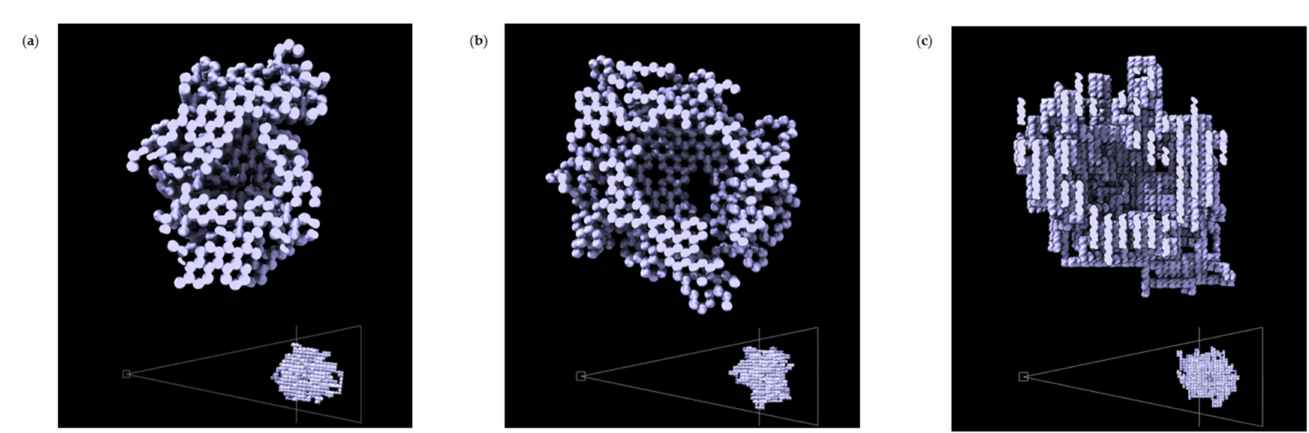
Figure 10. Isometric view of the best shapes generated with shape annealing algorithm for the coating application: ( a ) Slice view of structures generated with the tetrahedron mesh as the inner bounds of the design space with a total length of 12,901 bp; ( b ) Slice view of structures generated with the snub cube mesh as the inner bounds of the design space with a total length of 15,729 bp; ( c ) Slice view of structures generated with the Stanford bunny mesh as the inner bounds of the design space with a total length of 19,285 bp.